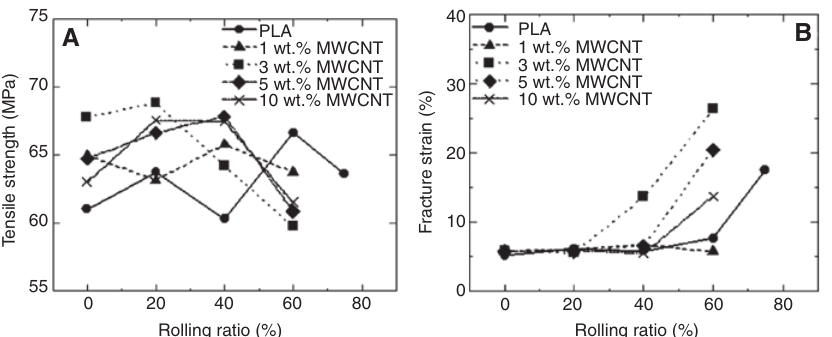
Figure 6: Tensile properties at various rolling ratios: (A) tensile strength and (B) fracture strain (perpendicular to rolling direction).